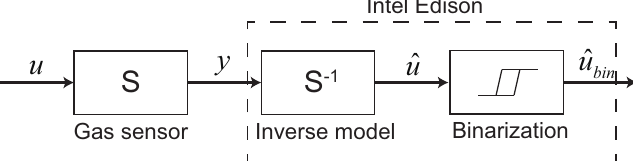
Figure 3. The flow of odor information processing using the ARX inverse